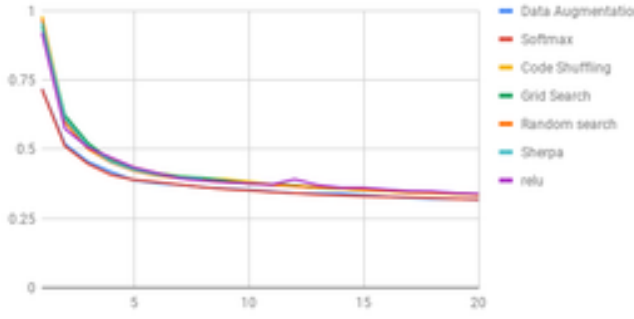
Figure 5. Graphical Representation of Capsnet optimisation and regularisation with reference to